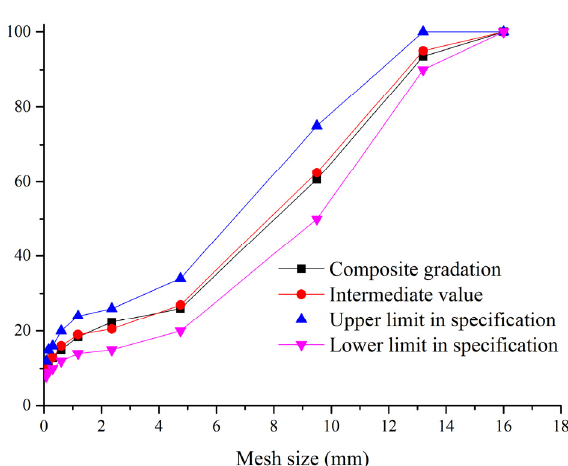
Figure 1. Gradation of the SMA ‐ 13 mixture.